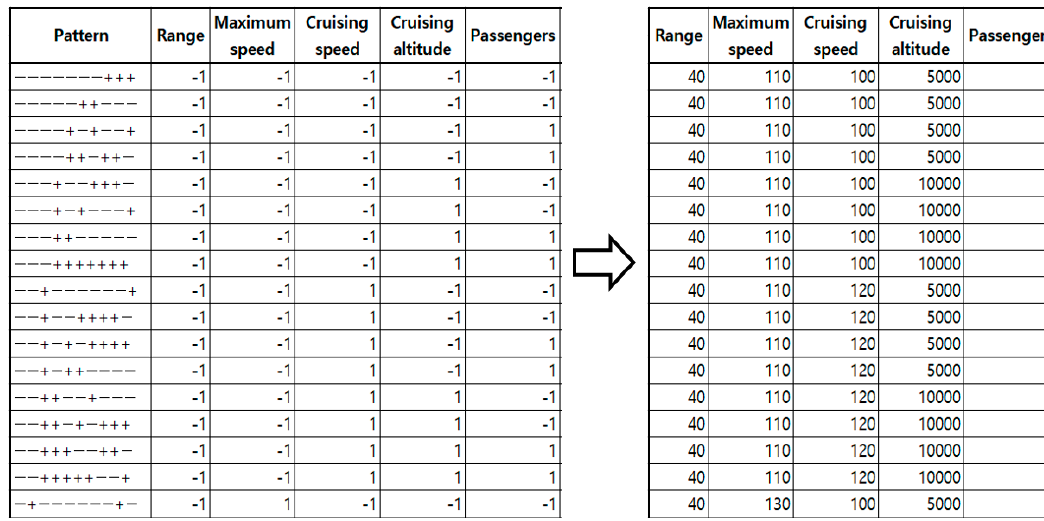
Figure 11. Converting fractional values to design parameter values.